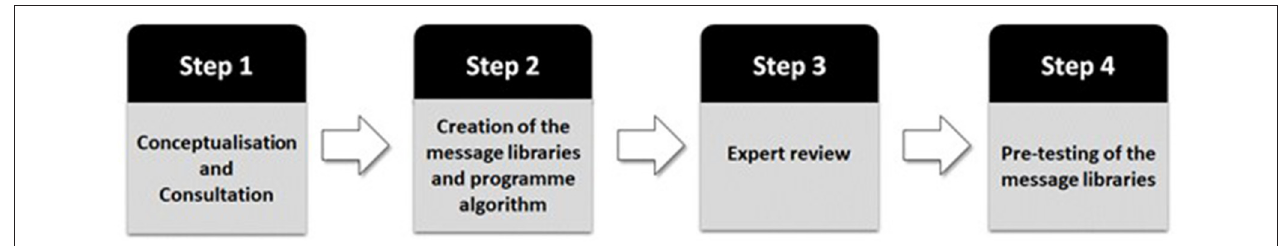
FIGURE 1 | Stages of development of the MyopiaEd